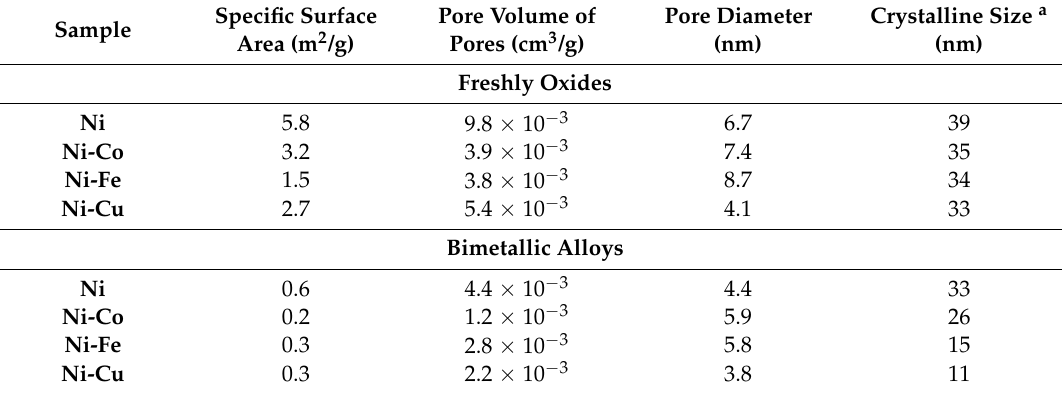
Table 2. Textural properties and crystal size of the fresh oxide and bimetallic alloy catalysts determined by N 2 adsorption and XRD.